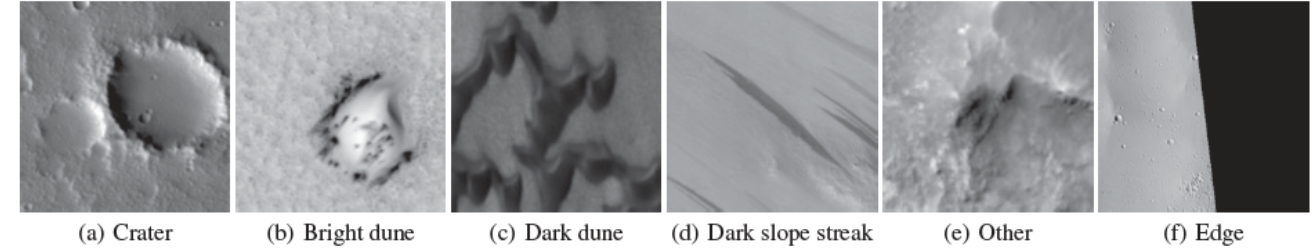
Figure 2. Example input images of each category for Deep Mars model.